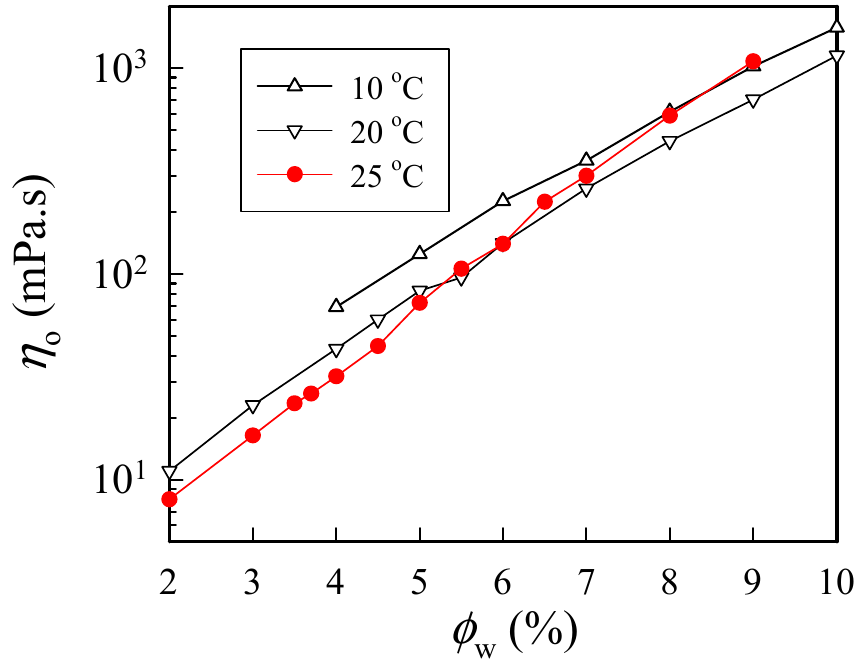
Figure 3. Concentration dependence of zero-shear viscosity of a-PNIPAM/H 2 O measured at different temperatures.